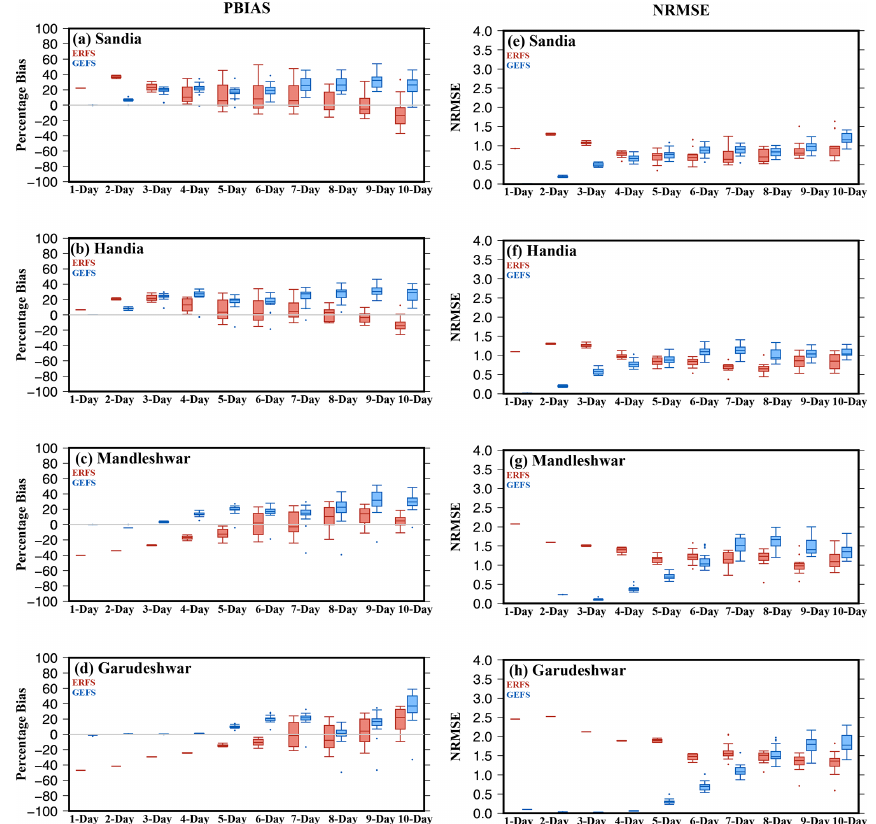
Figure 11. Comparison of ensemble streamflow forecast skills from ERFS and GEFS for 2019–2020. The forecast skill was evaluated considering the VIC-Res simulated streamflow with the observed forcing from IMD due to unavailability of observed